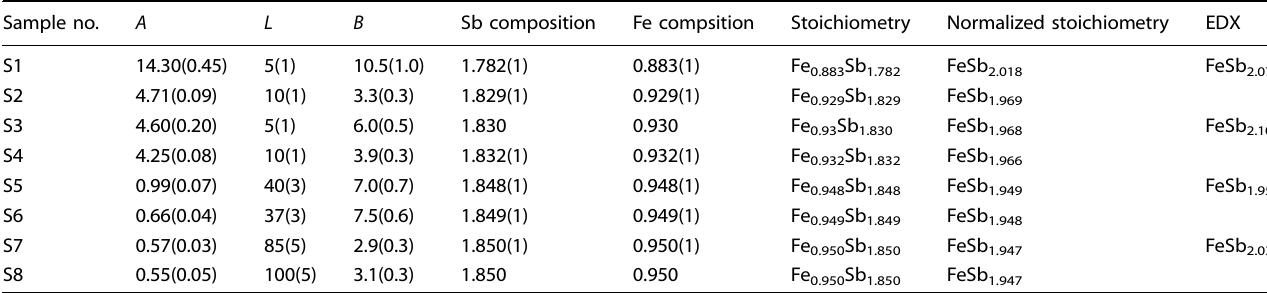
Table 1. Fitting parameters of the Callaway model for the thermal conductivity and the stoichiometry for all the samples (see text). Sample no. A L B Sb composition Fe compsition Stoichiometry Normalized stoichiometry